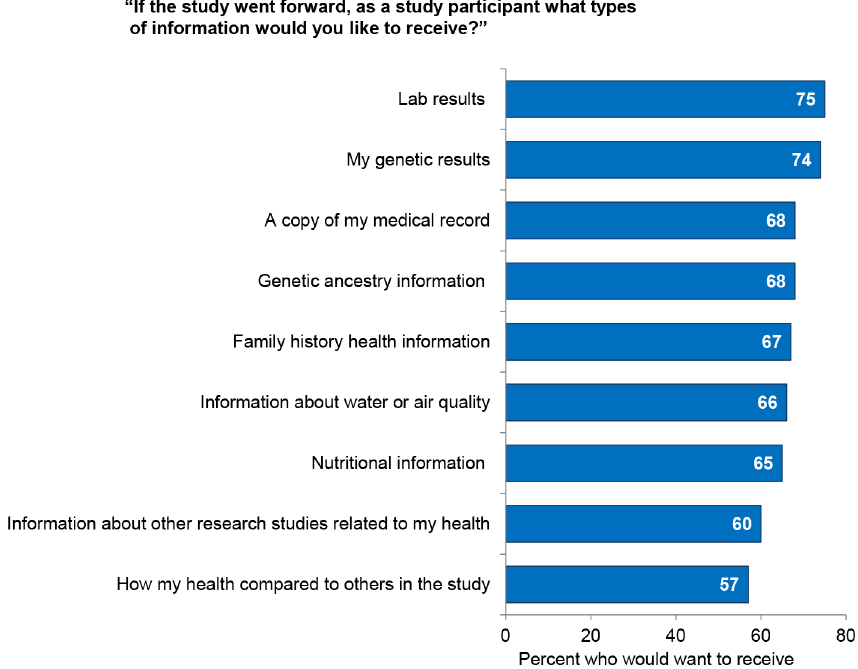
Fig 1. Results of a survey of 2,601 U.S. adults about participation in a nationwide longitudinal study of genes and environment. Respondents ’ interest in different types of information the study could return to